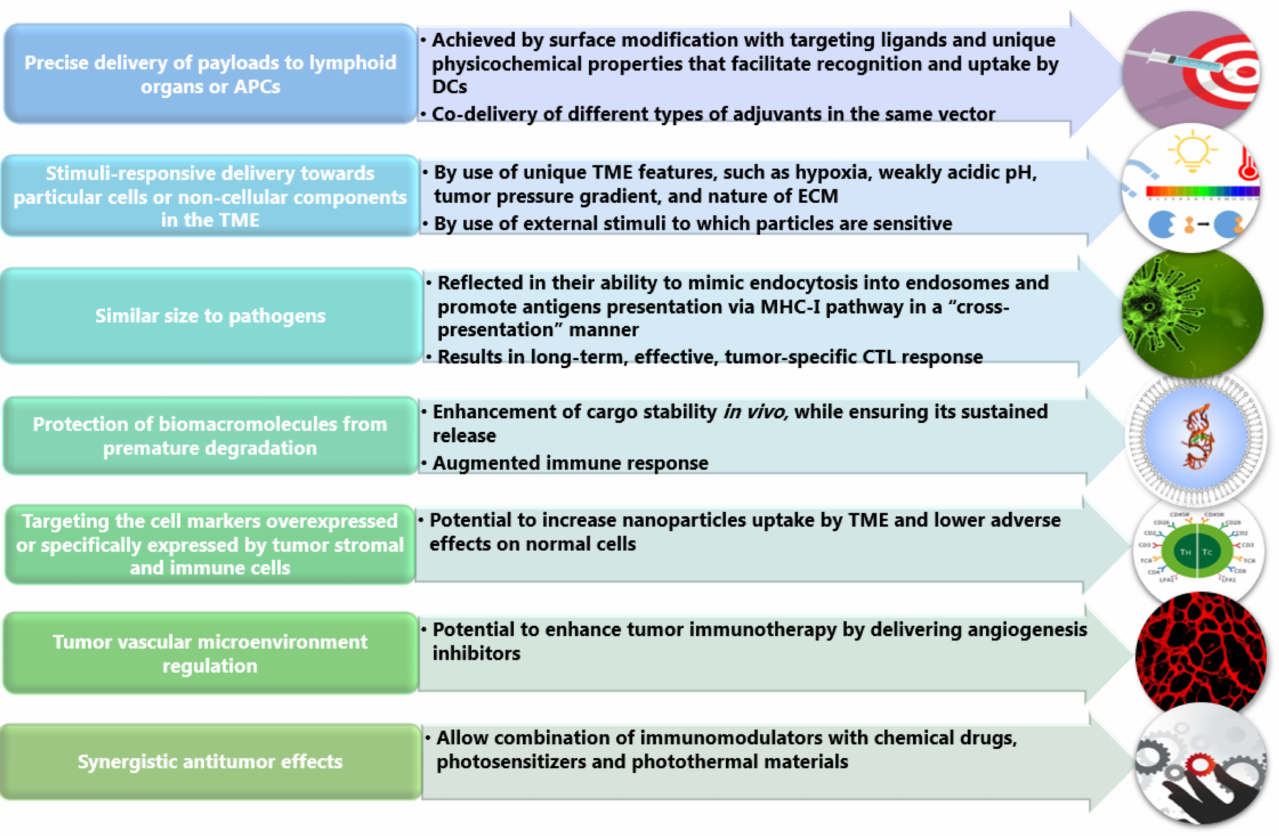
Figure 2. NPs roles in regulating TME and improving tumor immunotherapy. Created based on information from [1,30,34–36]. Abbreviations: APCs—antigen-presenting cells; DCs—dendritic cells; TME—tumor microenvironment; ECM—extracellular matrix; MHC—major histocompatibility complex; CTL—cytotoxic T